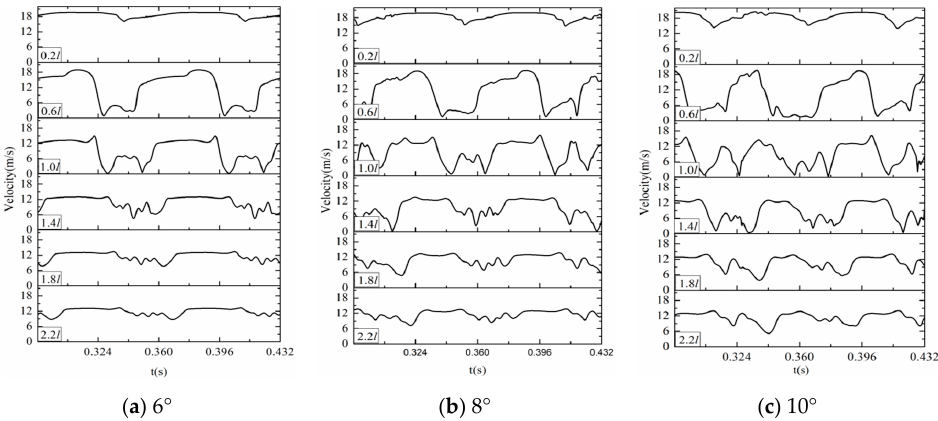
Figure 11. Monitoring point velocity curve of hydrofoil with different attack angles in two periods.